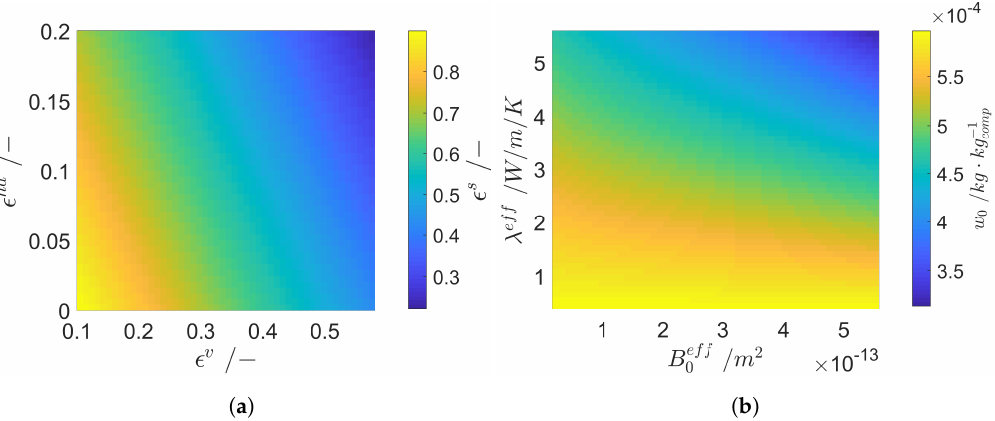
Figure 3. Parameter space of dry (no methanol adsorbed) adsorbent-compounds calculated with our material model. ( a ) Material space represented with the three volumetric proportions. ( b ) Material space with corresponding transport parameters and adsorption capacity.